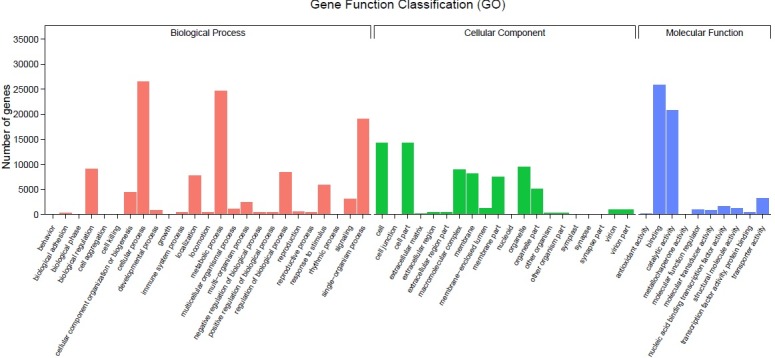
Functional classification of GO terms of sea buckthorn transcripts.Note: The number of genes in a specific sub-category within the main category is shown on the y-axis; the name of the sub-category is shown on the x-axis.